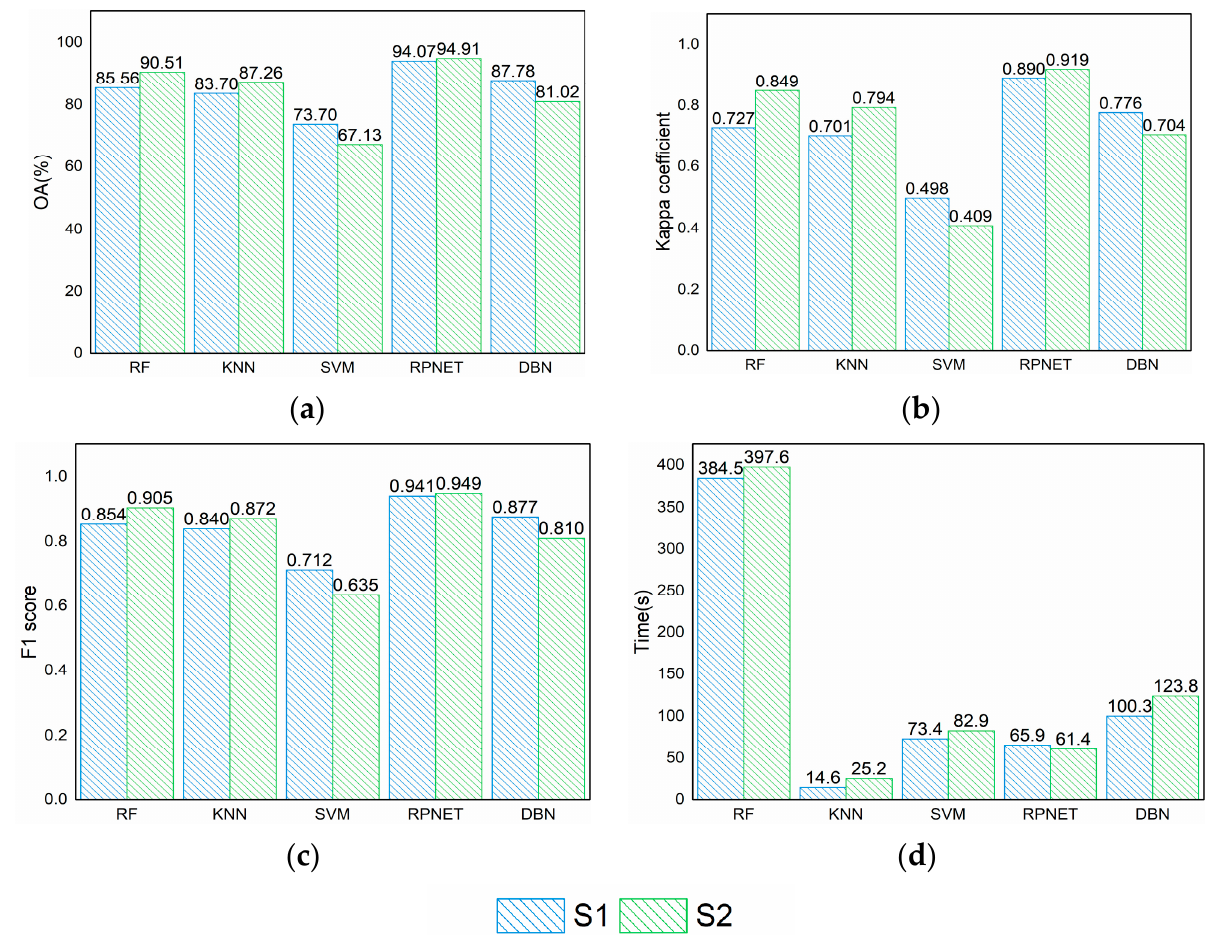
Figure 9. Accuracy evaluation results of the RPNet and the traditional classification methods. ( a ) OA; ( b ) Kappa coefficient; ( c ) F1 score; ( d ) running time.